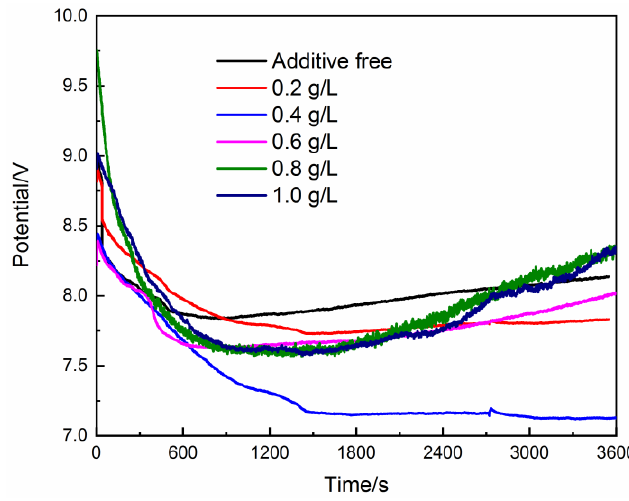
Figure 2. Cell potential curve of electrolytic reaction.